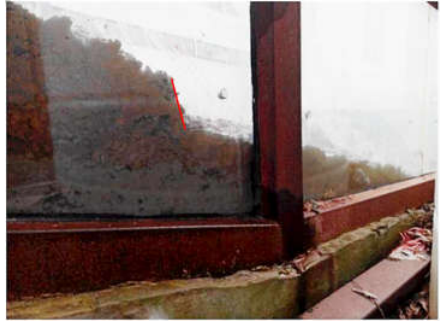
Figure 8. Vertical crack at the back edge of the slope (Test 1).